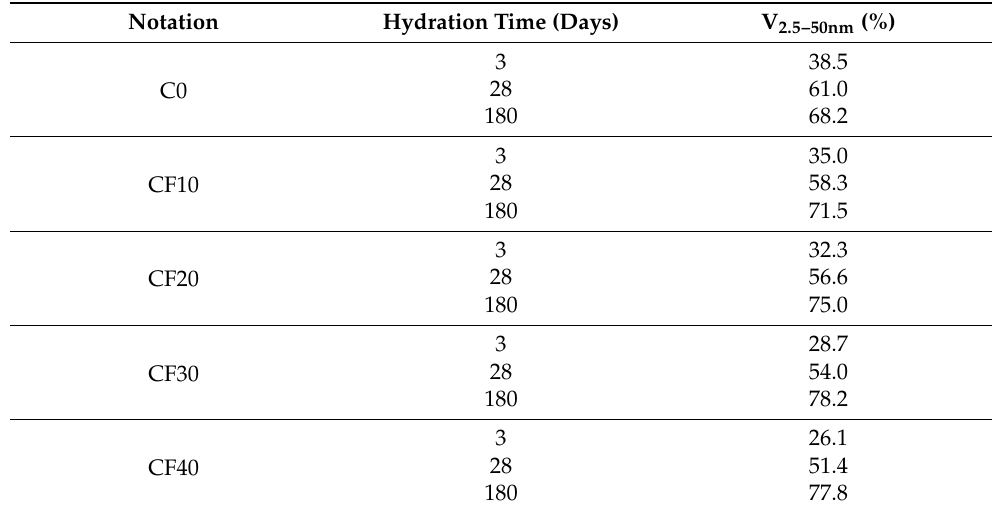
Figure 8. Correlations between D s and fly ash dosage at ( a ) 3 days, ( b ) 28 days and ( c ) 180 days.